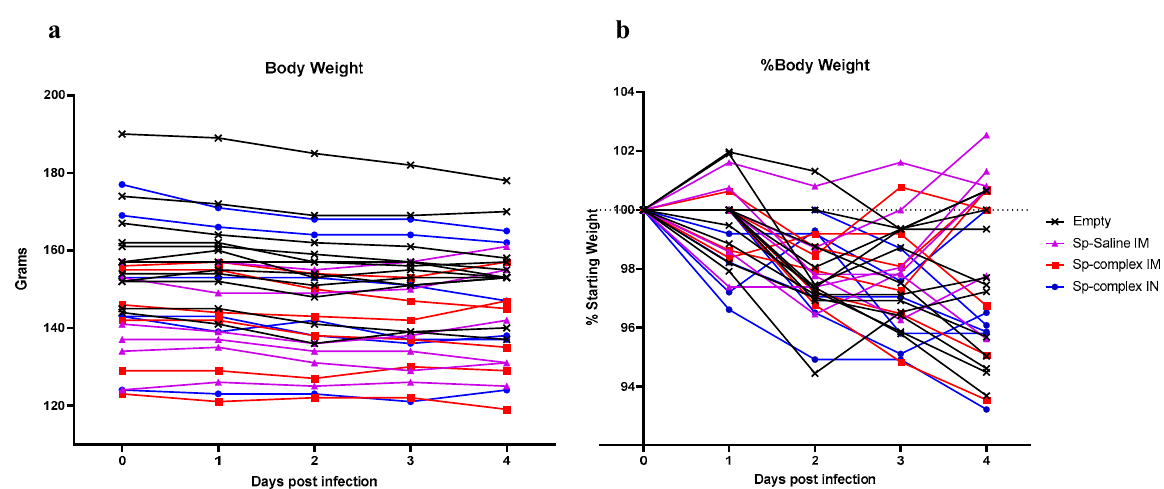
Figure A2. Prime-Boost Hamsters Detailed Body Weights. Prime-boost hamsters were divided into three spike-vaccinated groups receiving Sp_pVax1 IM vaccination of 100 µg DNA diluted in saline (Sp-Saline IM), IM vaccination of 50 µg Sp_pVax1 DNA complexed to in vivo delivery reagent (Sp-complex IM), and IN vaccination of 50 µg Sp_pVax1 DNA complexed to in vivo delivery reagent (Sp-complex IN). N = 12 for empty pVax1 group and N = 6 for Sp-vaccinated groups. Detailed body weight over course of infection for individual hamsters is shown as ( a ) exact body weight in grams or ( b ) percent body weight.